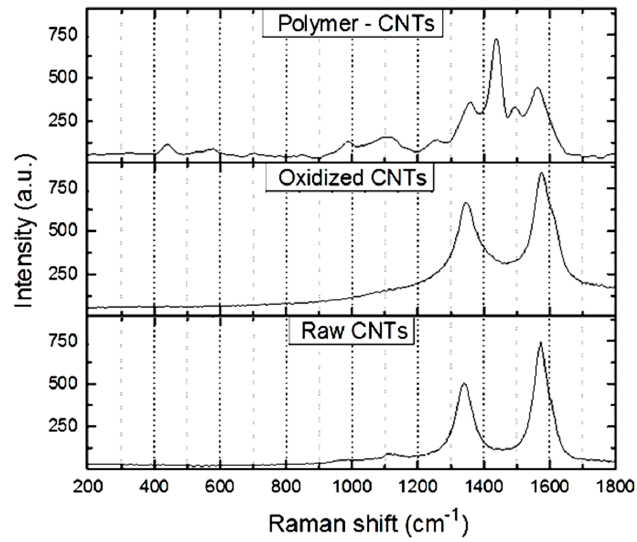
Figure 1. Raman spectra of the raw, oxidized and polymer functionalized carbon nanotubes.